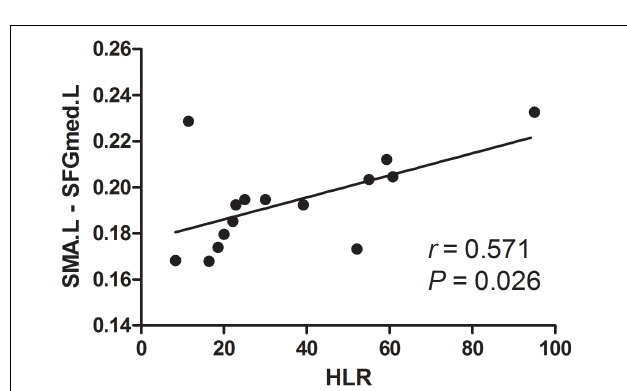
FIGURE 3 | Correlation between abnormal DFC and tinnitus severity. HLR, hearing level of the right ear; L, left; SFGmed, superior frontal gyrus, medial part; SMA, supplementary motor